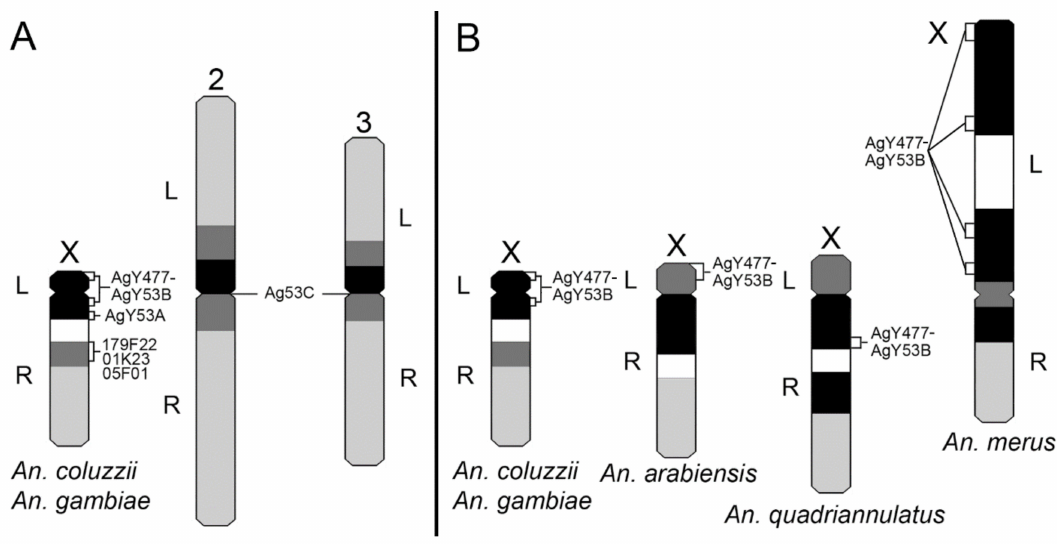
Figure 8. Idiograms of metaphase karyotypes of species from the An. gambiae complex. ( A ) An idiogram of metaphase karyotypes of An. gambiae and An. coluzzii . ( B ) Comparison of the X chromosome idiograms among species from the An. gambiae complex. Left and right arms are labeled with L and R, respectively. Black bands correspond to condensed heterochromatin. Dark gray bands correspond to di ff use heterochromatin. White areas represent the rDNA locus. Light gray areas show euchromatin. The area of constriction represents the putative centromere. Mapping of the BAC clones and satDNA repeats AgY53A and AgY53C were performed only with An. coluzzii or An. gambiae . Two di ff erent positions of AgY477–AgY53B on the X chromosome of An. gambiae and An. coluzzii represent polymorphism among